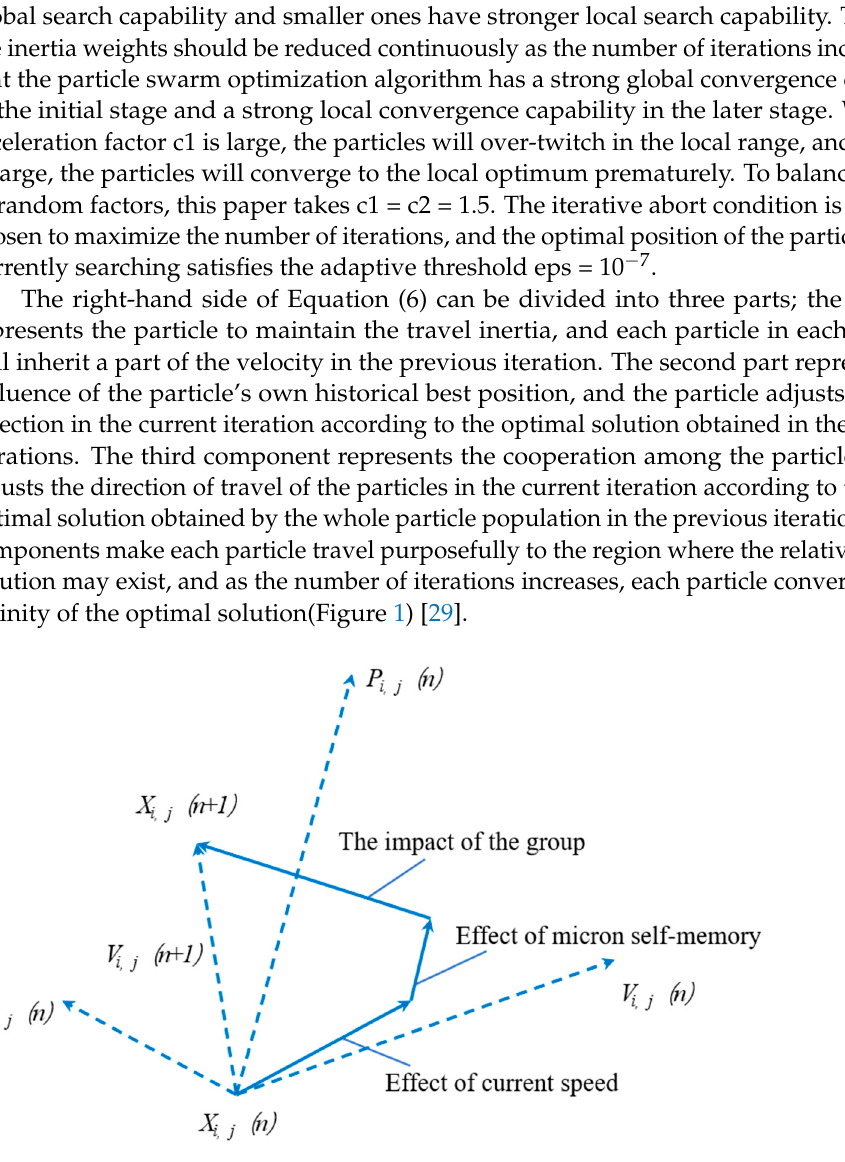
Figure 1. Particle swarm optimization schematic.